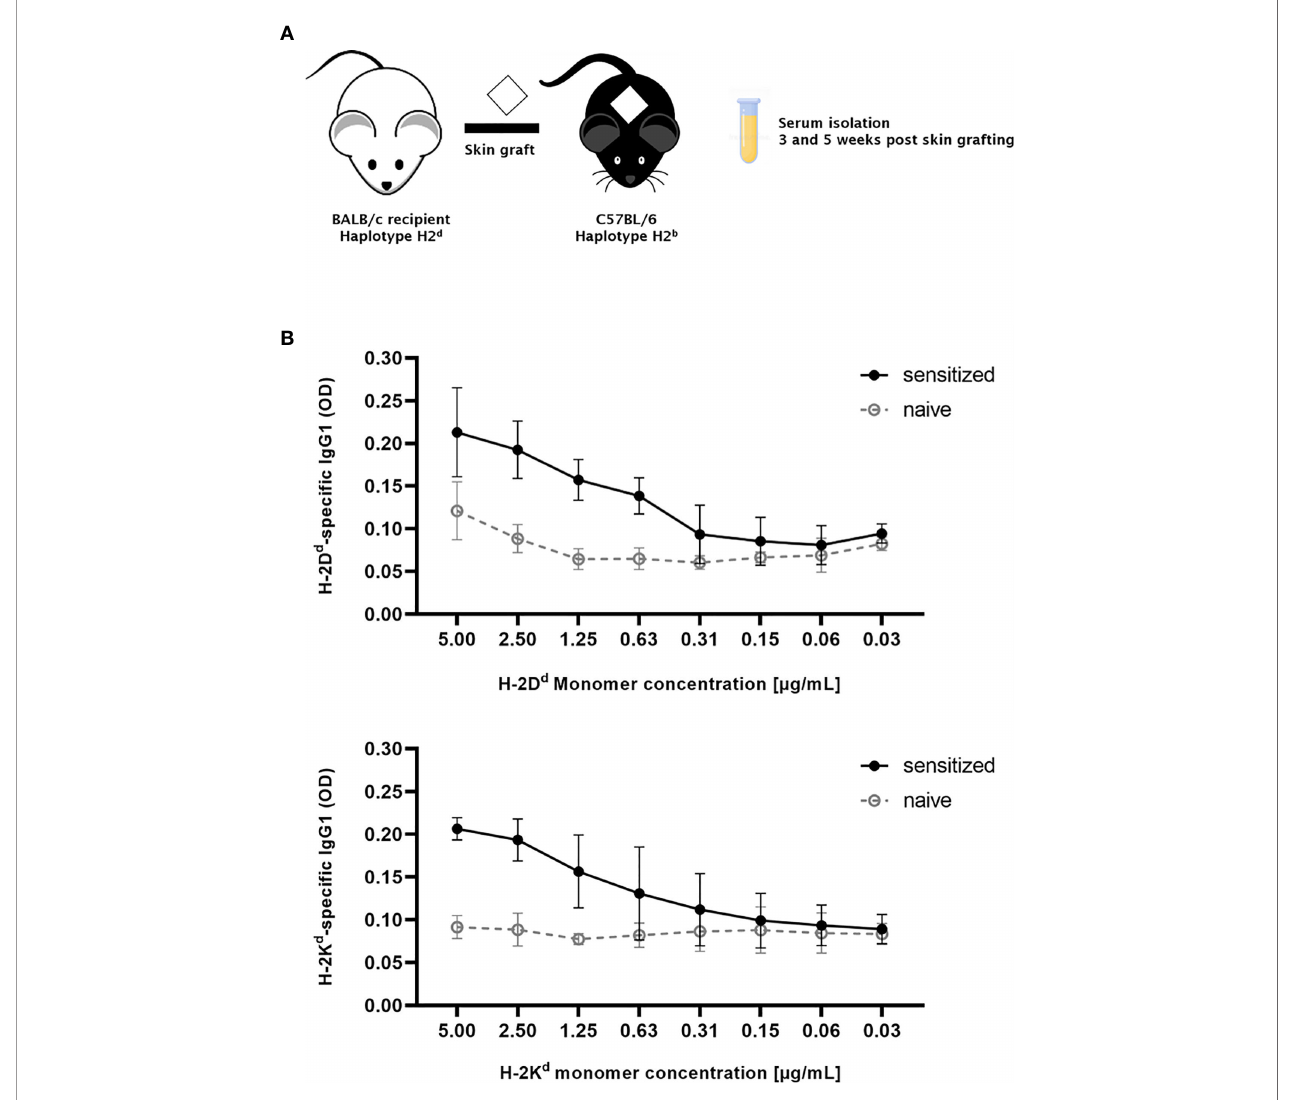
FIGURE 4 | Titration of MHC monomers. (A) Schematic illustration of the experimental set up. C57BL/6 mice were grafted with fully mismatched BALB/c skin grafts. Serum was isolated 3 and 5 weeks post skin grafting. (B) For detection of the appropriate monomer concentration, plates were coated with MHC class I monomers (H-2D d , H-2K d ) diluted from 5 to 0.03 µg/ml, followed by incubation with either sensitized serum from C57BL/6 mice after rejection of a BALB/c skin allograft, or with naive serum as negative control. Results from two independent experiments are shown. Serum in each experiment was pooled and individual values were measured in